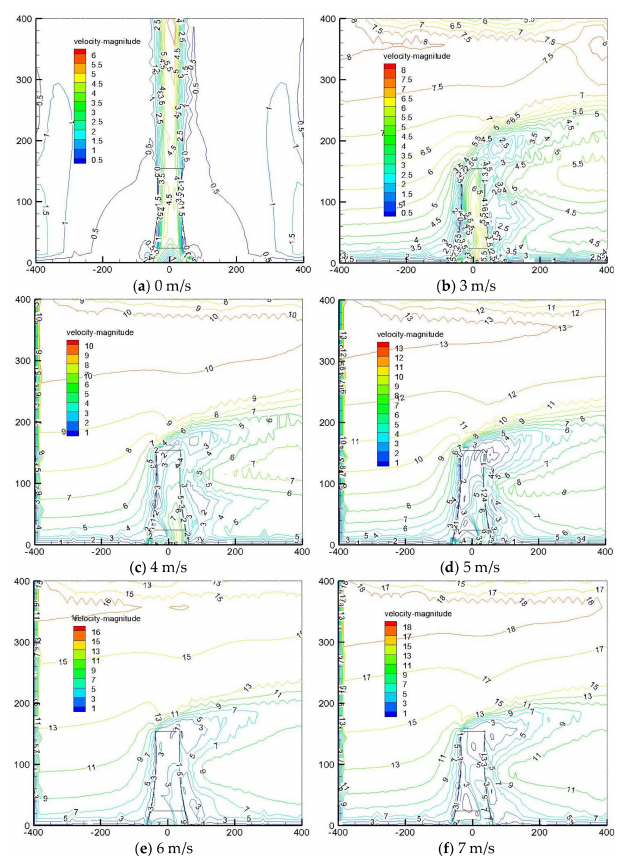
Figure 11. Air velocity contour at crosswind speeds of ( a ) 0 m/s, ( b ) 3 m/s, ( c ) 4 m/s, ( d ) 5 m/s, ( e ) 6 m/s, and ( f ) 7 m/s.